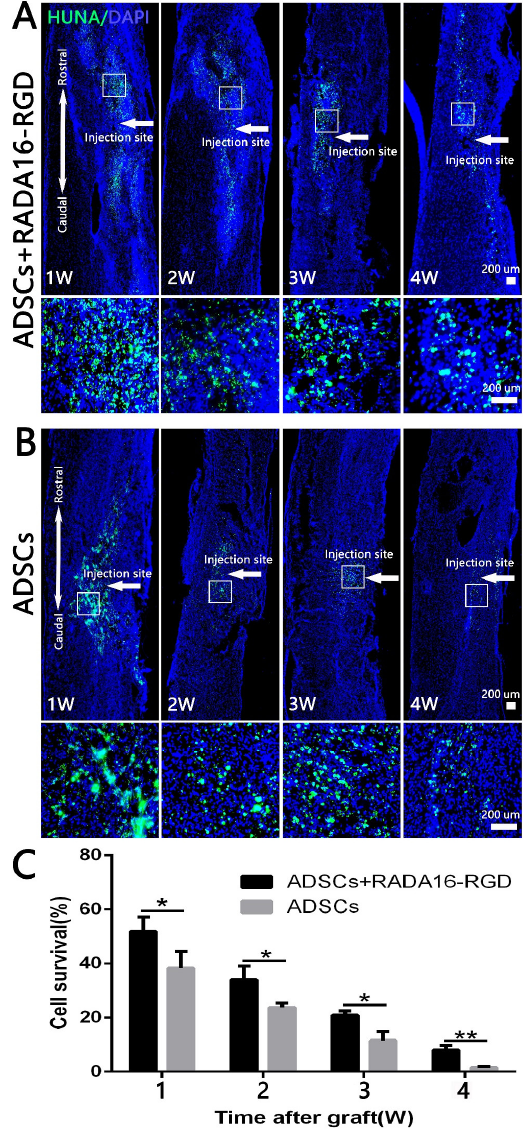
Figure 2. ADSC survival at different time points after transplantation. HUNA antibody staining was performed in the spinal cord at 1–4 weeks after adipose stem cell transplantation, and the HUNA + cells were distributed at the injury site around the injection point (arrow). ( A ) ADSCs+RADA16-RGD group. ( B ) ADSCs group. In both the groups, a large number of HUNA + cells were observed in the first 1–3 weeks after the ADSCs transplantation, and there were fewer HUNA + cells in the 4th week. The panels below ( A , B ) show high magnification of the boxed regions in the above panels. ( C ) The amount of surviving adipose stem cells decreased over the lapse of transplantation time in two groups. The ADSC survival rate in the ADSCs+RADA16-RGD group at 1, 2, 3, and 4 weeks was significantly higher than that in the ADSCs group at 1, 2, 3, and 4 weeks. * p < 0.05, ** p < 0.01. Data are presented as mean ± SEM ( n = 3 per time point). Scale bar = 200 um. HUNA: human nuclear